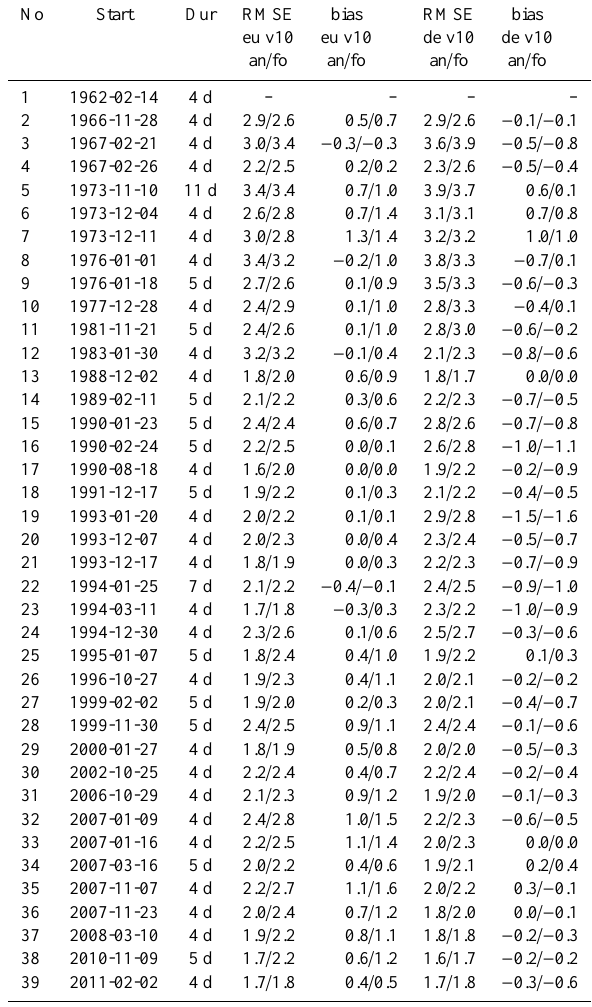
Table 1. Catalogue of the 39 historical storm floods and the RMSE and bias of the wind speed (v10, ms − 1 ) for COSMO-eu (eu) and COSMO-de (de) forecast runs (fo) and nudging runs (an). The first three columns show the storm number (No), the start date (UTC) and the duration (Dur) of a storm (in days, d). An event lasts from approximately 3 days before the main maximum water level until one or two low tides later. Simulations start at 00:00 UTC of the first day and end at 24:00 UTC of the last